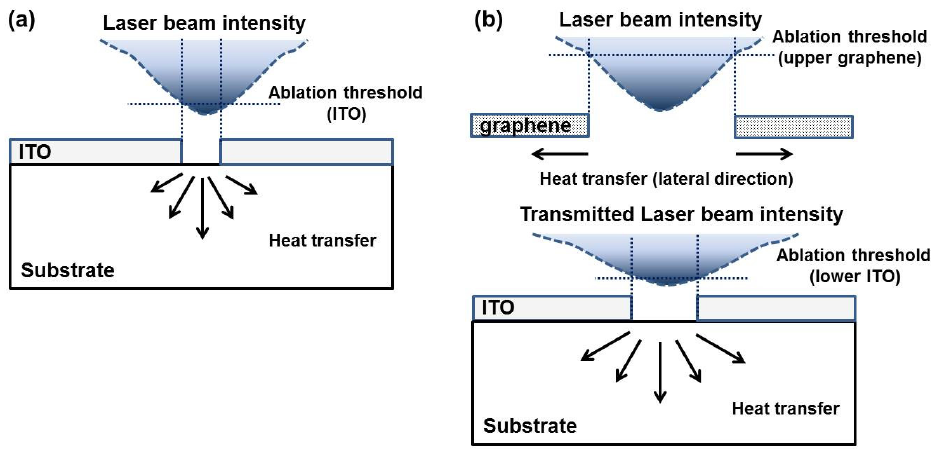
Figure 5. Schematic diagram of the thermal energy transfer of laser beam through ( a ) ITO single layer and ( b ) graphene/ITO double layer during laser ablation.